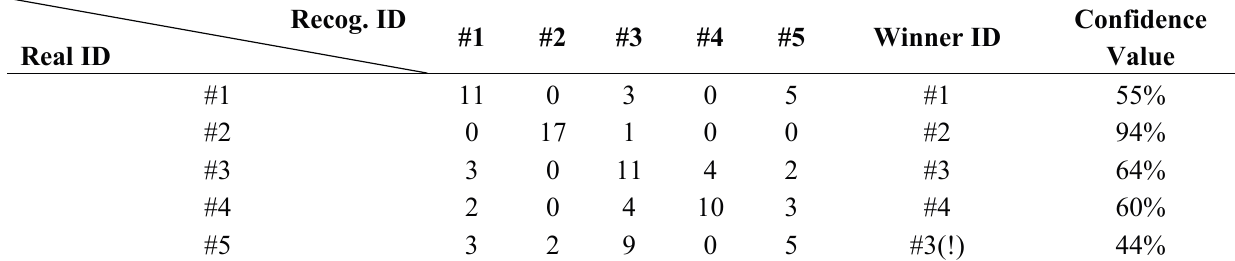
Table 5. Vote matrix of the proposed human identification solely based on FCT.